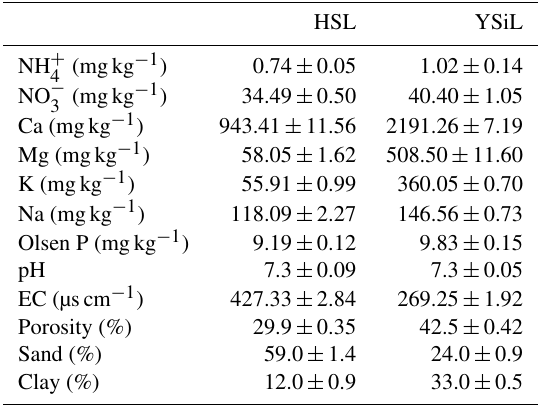
Table 2. Select physical and chemical properties of Hanford Sandy